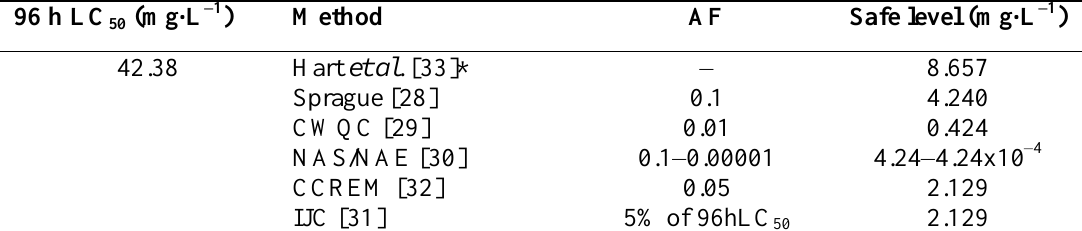
Table 3. Estimate of safe level of atrazine at 96 h exposure time in C. punctatus